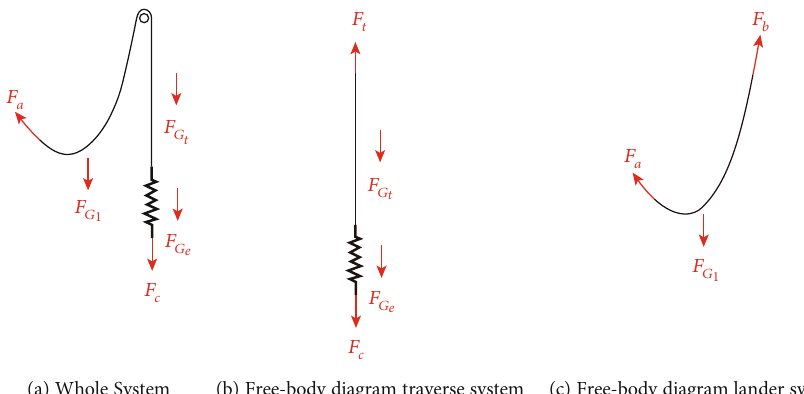
Figure 9: Free-body principle for a rope in NEST experimental setup. Intersect the rope at the turning wheel leads to virtual forces F traverse) and F b (at virtual suspension point b ) which have to be equal for satisfying equilibrium of forces at the whole system. The weight force F G is divided into its three parts, F G